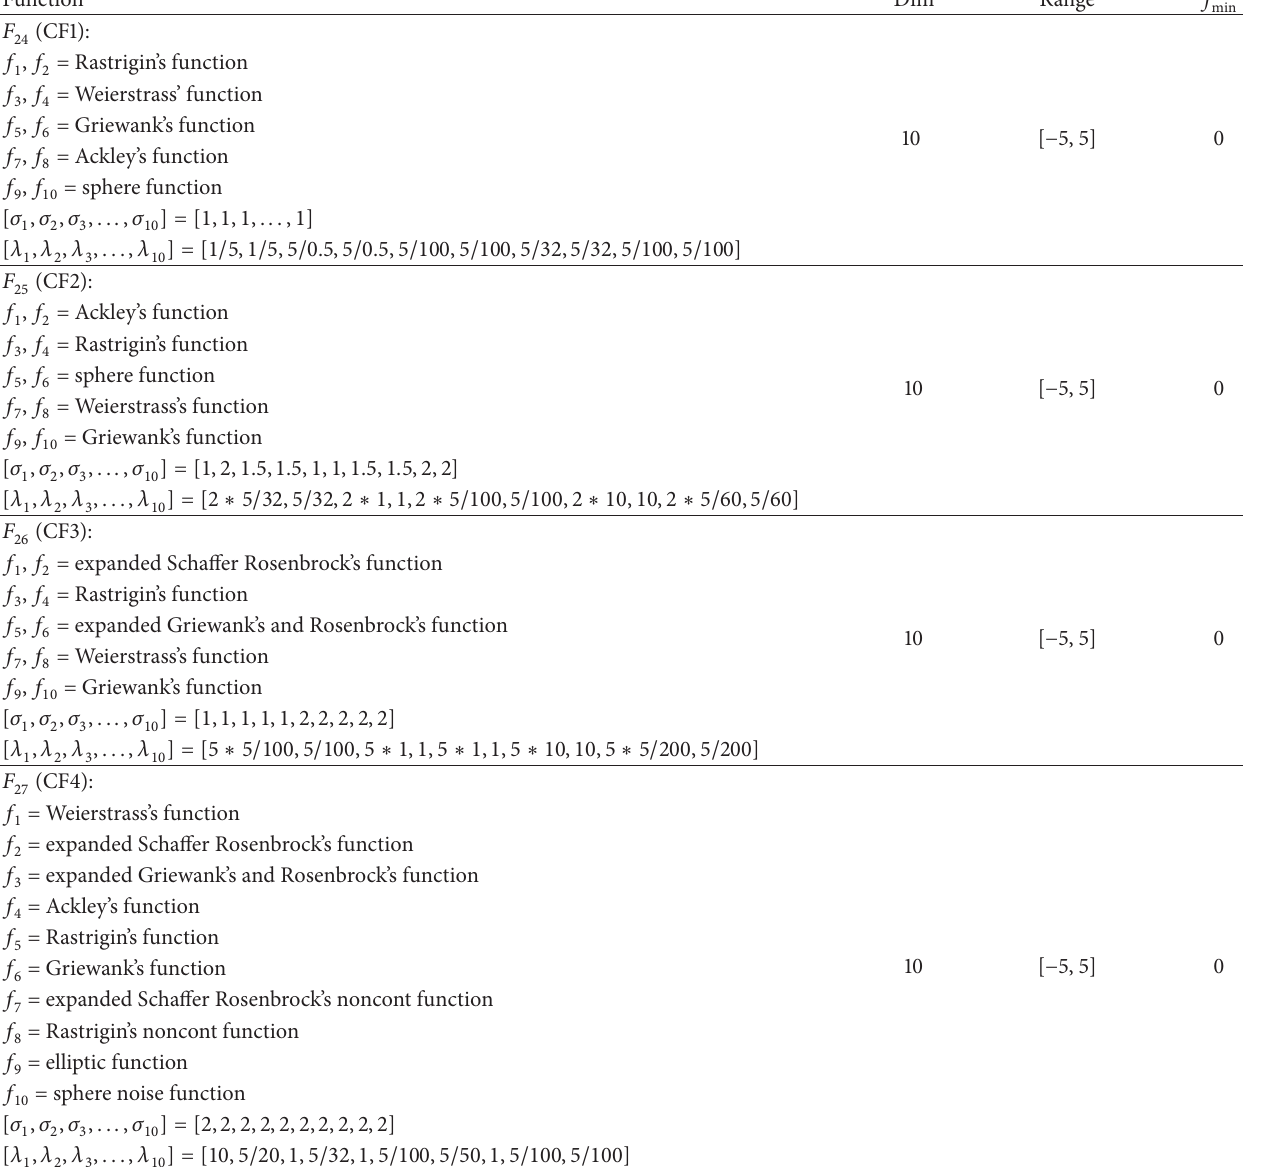
Table 4: Composite benchmark functions.